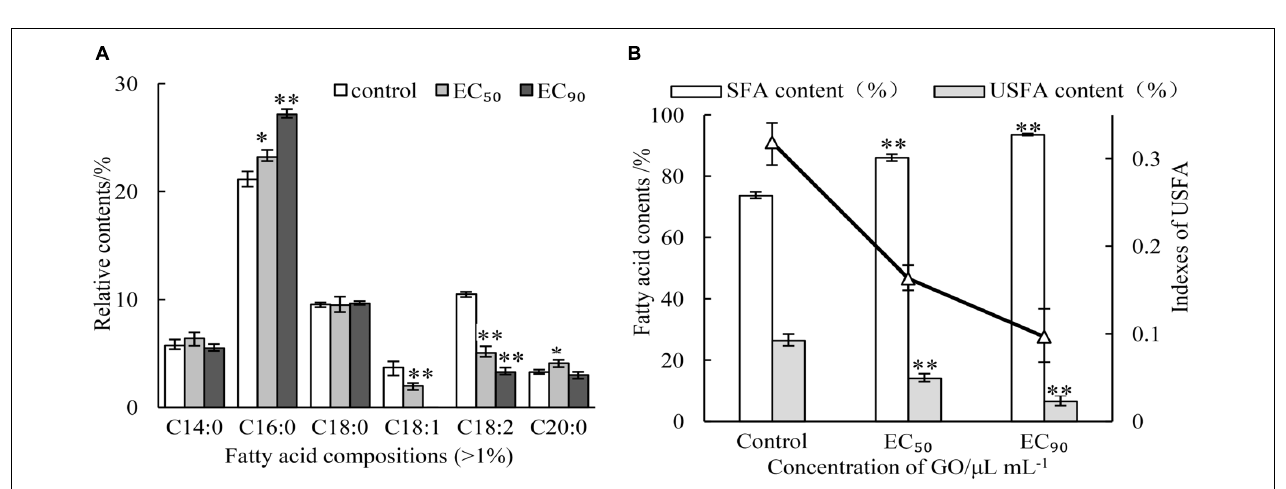
FIGURE 5 | Effects of different concentrations of GO on fatty acid compositions (A) and indexes of unsaturated fatty acid (B) . Each value is the mean for three replicates. The vertical bar indicates the standard error. The asterisks indicate significant difference between control and GO treated fruit ( ∗∗ P < 0.01, ∗ P < 0.05).